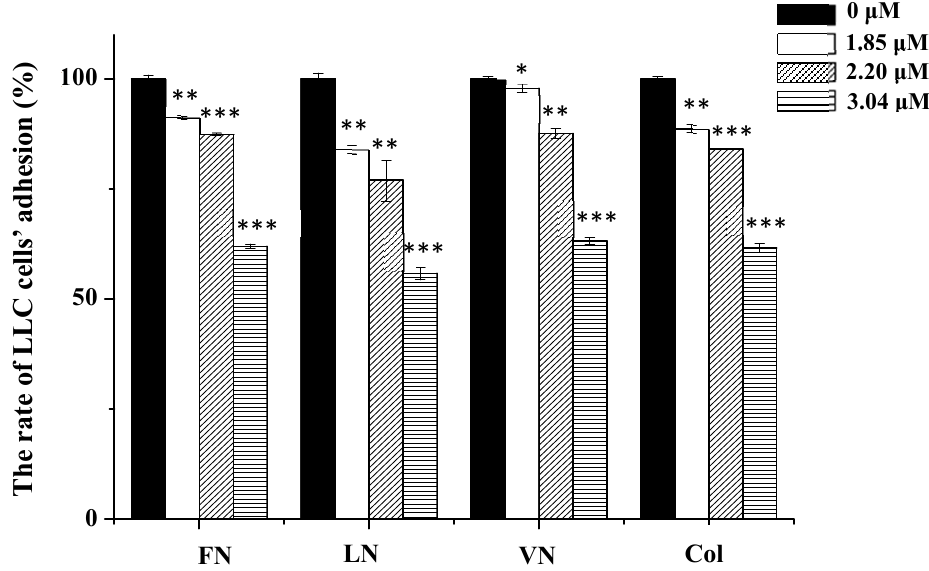
Figure 9. rAj-Tspin inhibited the adhesion of LLC cells. *, ** and ***, respectively, indicate p < 0.05, p < 0.01, and p < 0.001 (compared with the empty-medium groups). Table 1. Adhesive rates of LLC cells to the four ECM proteins in the presence of rAj-Tspin. rAj-Tspin ( μ M).